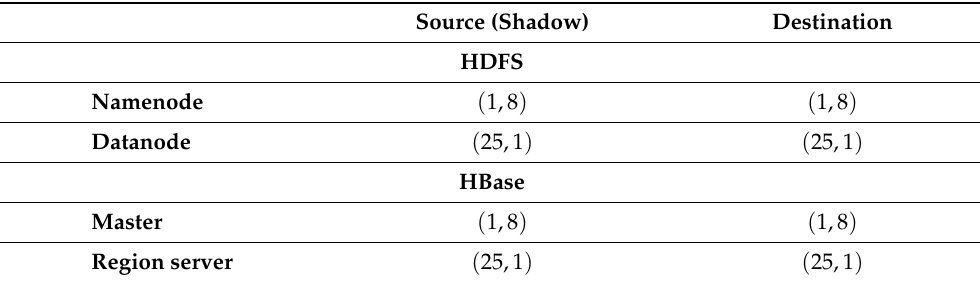
Table 3. Configurations of source, shadow, and destination clusters (here, ( x , y ) indicates the number of x nodes and y the Gbytes of memory space per